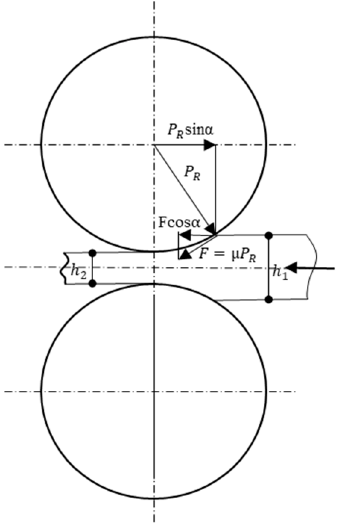
Figure 2. Schematic representation of the rolling process.